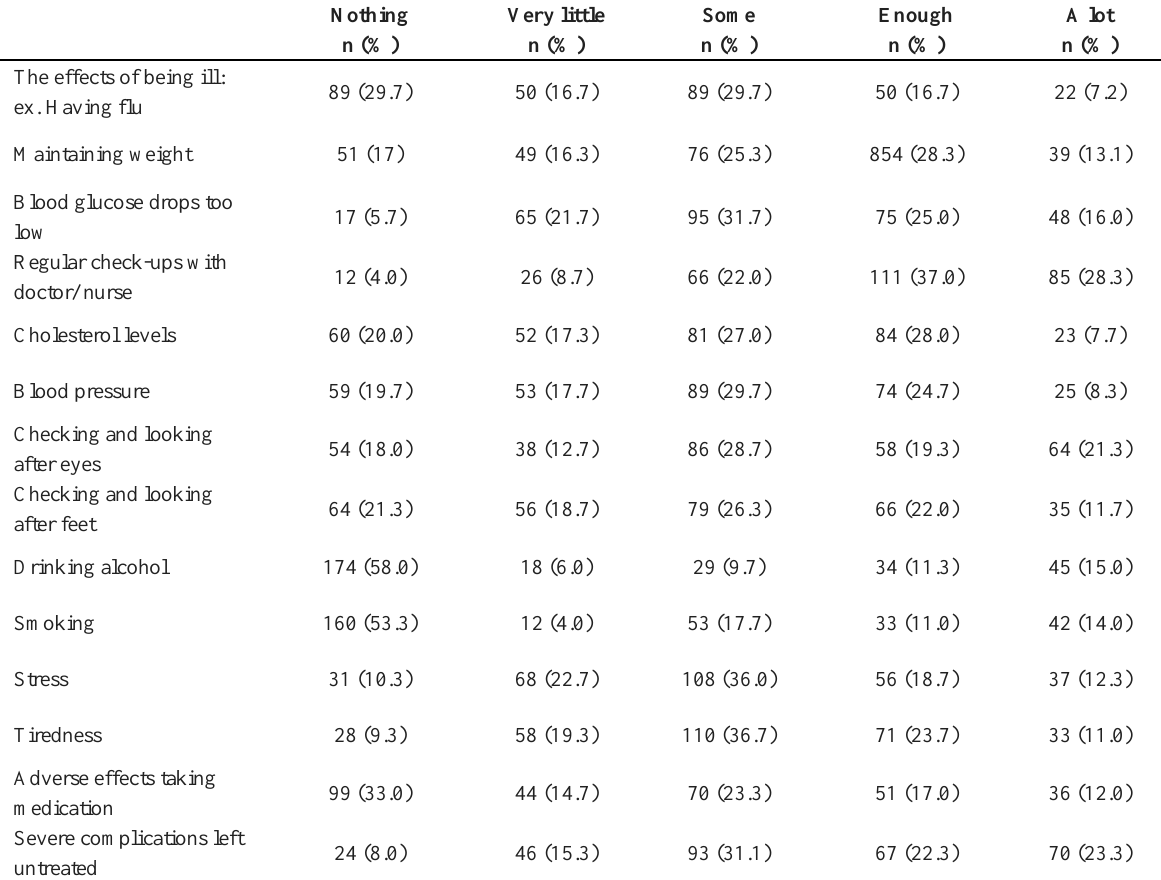
Table 5. Likert Scale Responses “To what extent do you understand the following factors in relation to your